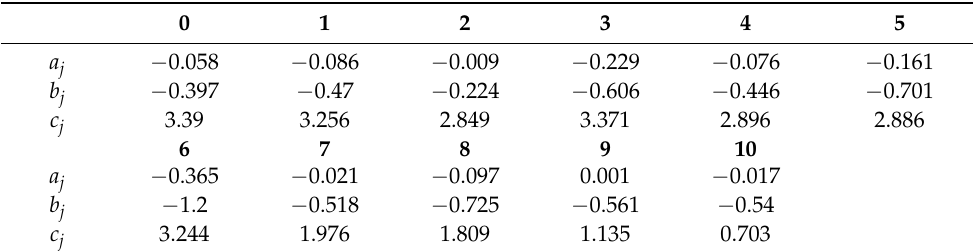
Table 1. Estimated Coefficients of the Fractal Curve.